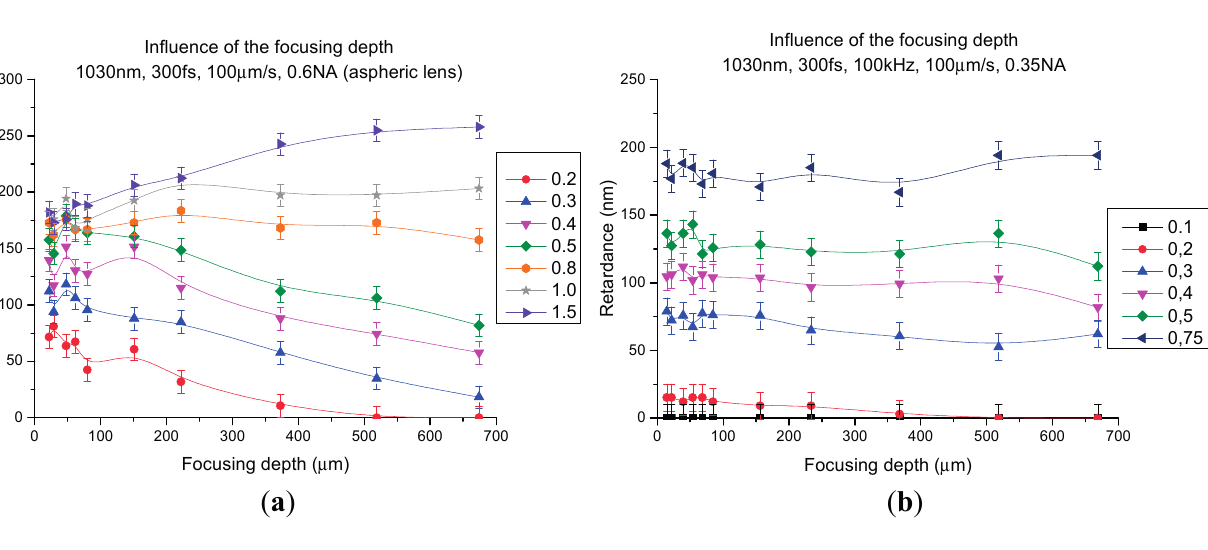
Figure 3. Influence of the focusing depth of the laser induced retardance for various pulse energies for ( a ) 0.6 NA aspheric lens and ( b ) 0.35 NA microscope objective. The others laser parameters are as follows: 1030 nm, 300 fs, 100 kHz, 100 μ m/s, and polarization parallel to the scanning direction ( Xx